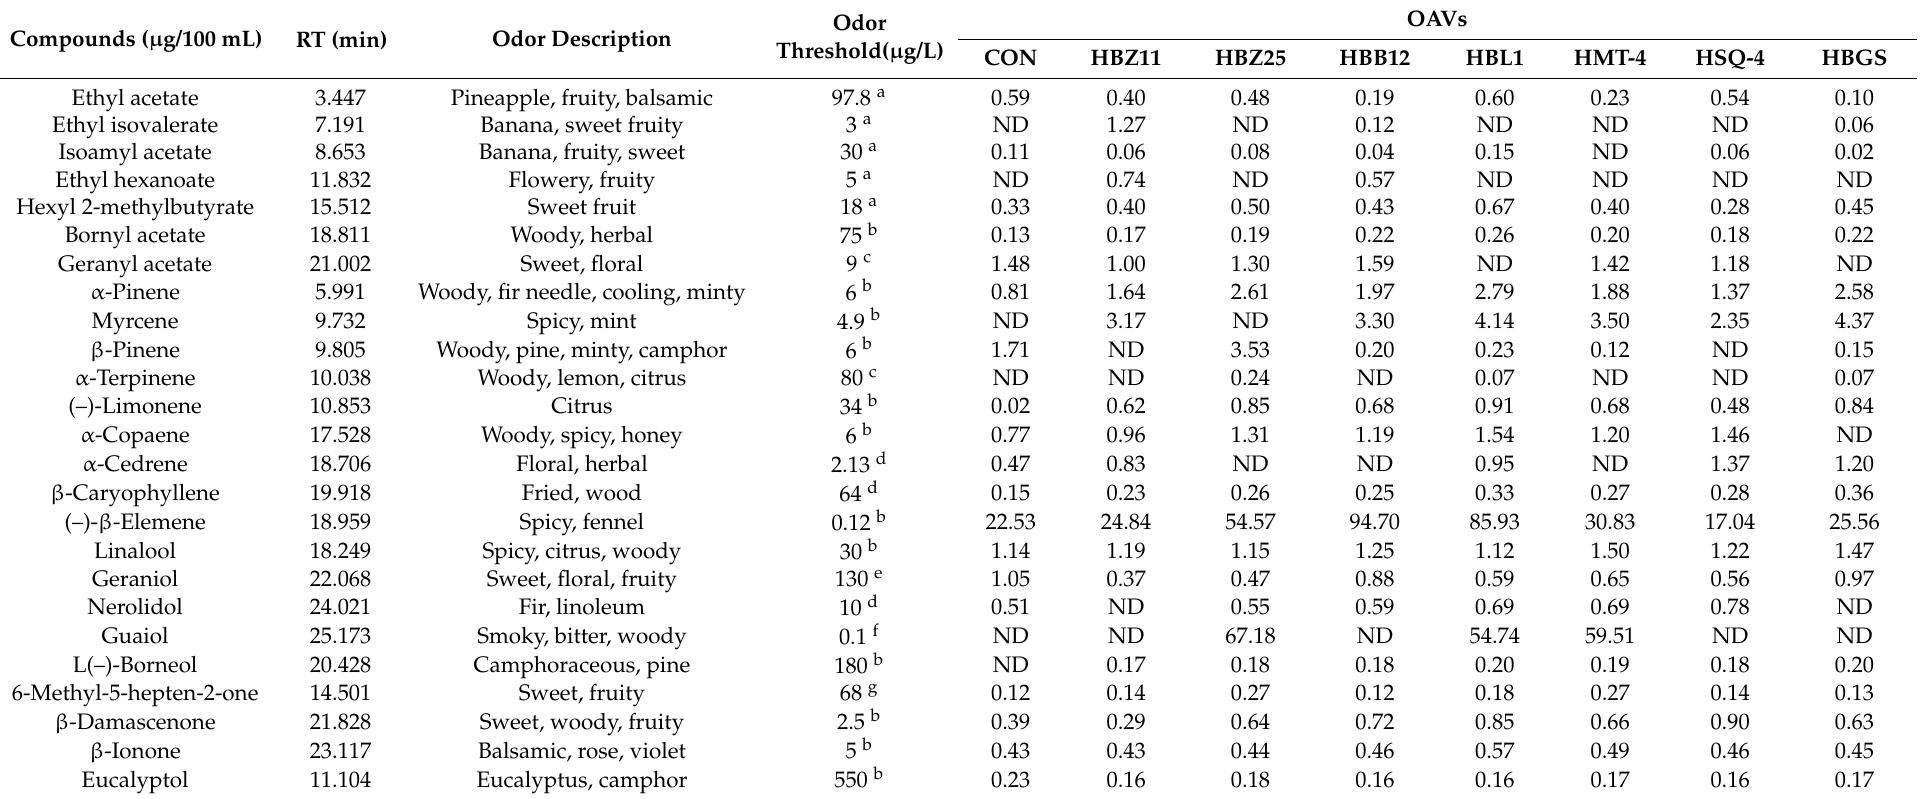
Table 3. The retention time (RT), odor descriptions, odor thresholds (OT), and odor activity values (OAVs) of aroma compounds in